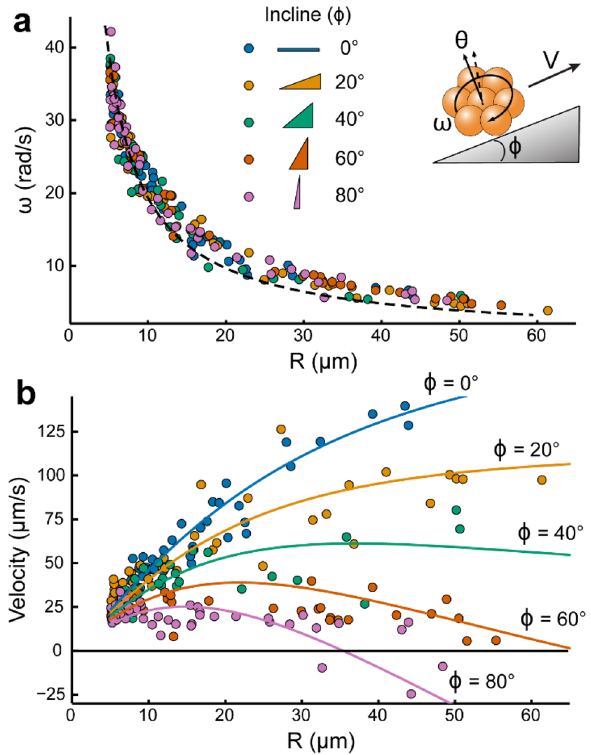
Figure 2. µWheel translation on inclines. ( a ) µWheel angular velocity ( ω ) as a function of size ( R ) and incline angle ( φ ). Dotted line shows the ω ∝ 1 / R scaling. (inset) Translating µwheel on an incline. ( b ) µWheel velocity over incline angles 0–80° with solid lines the variable gap width model (Supplementary Equation 1). All µwheels were propelled with a constant 40 Hz circular rotating field of magnitude 3.7 mT and 30° camber angle